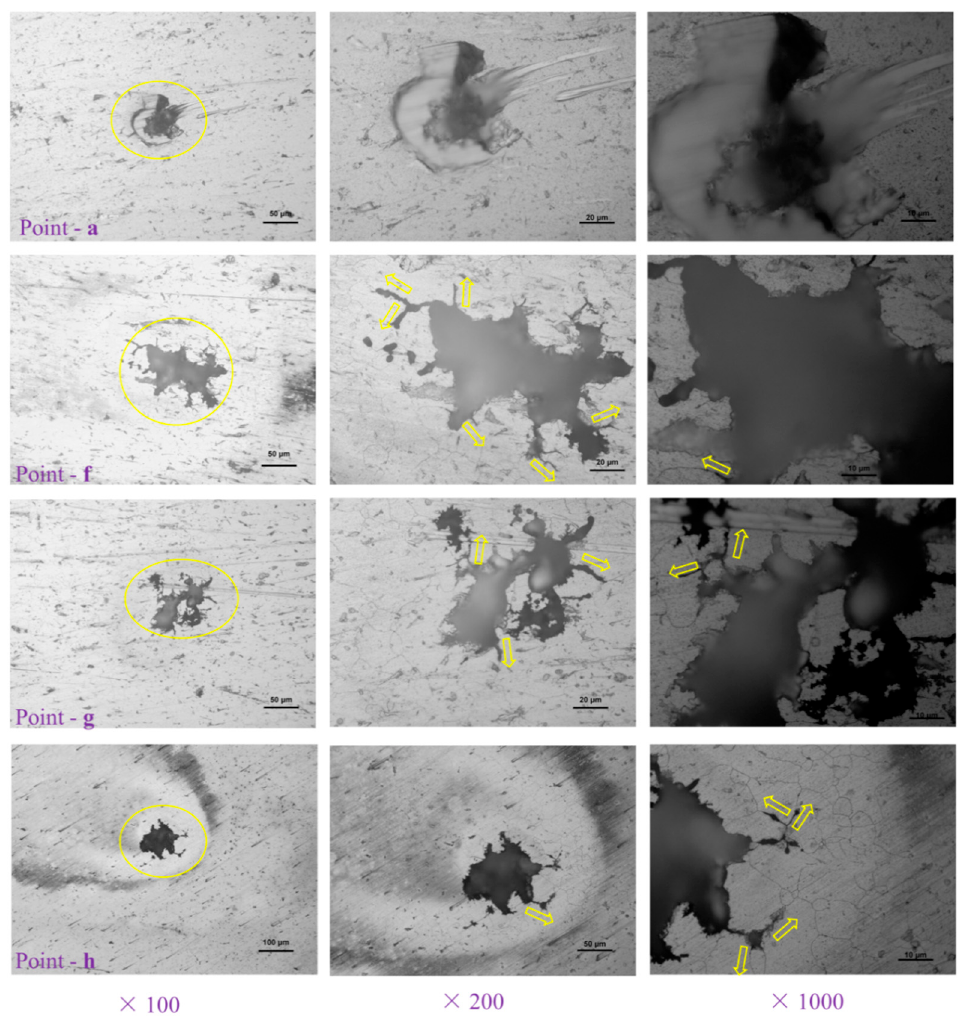
Figure 5. Morphologies of classical pits at various magnitudes of enlargement during measuring of their depths, the data of which are listed in Table 2. The yellow arrows highlight the initiation of cracks within the pit-to-crack transformation scheme.